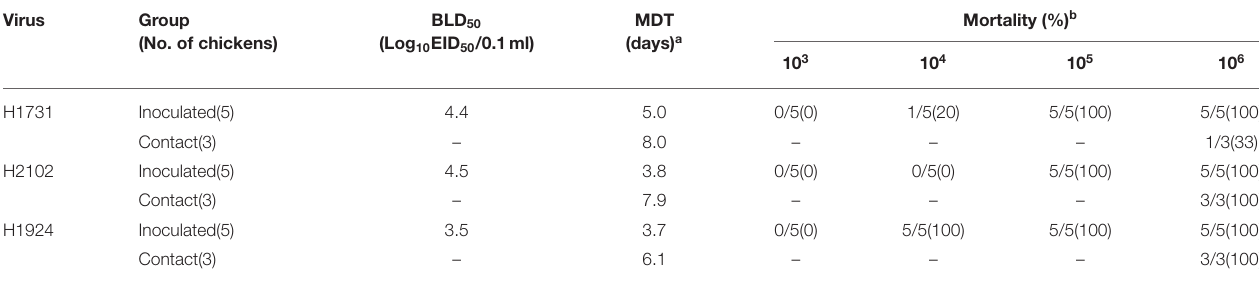
TABLE 1 | Pathogenicity and transmissibility of H1731, H2102, and H1924 in SPF chickens. Virus Group (No. of